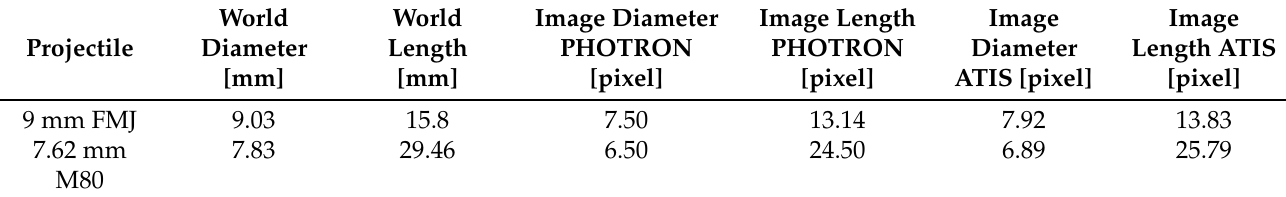
Table 2. Dimensions of projectiles in the world and image units.